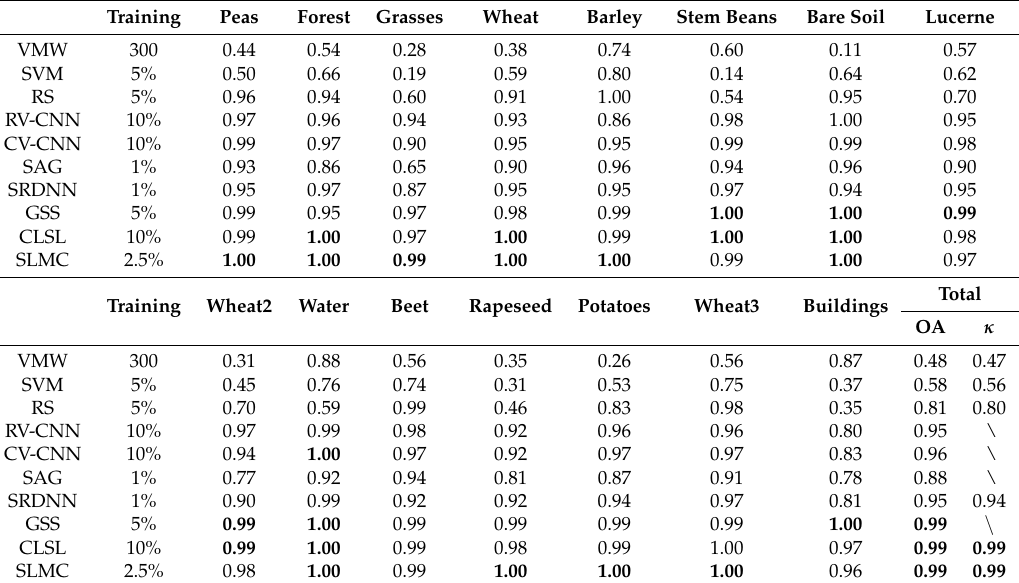
Table 3. Pixel and classification accuracies on the dataset Flevoland. Training